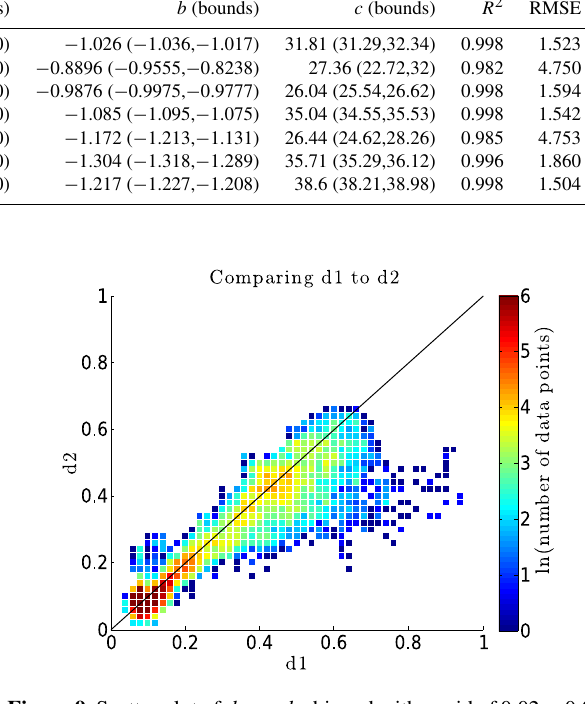
Figure 9. Scatter plot of d 1 vs. d 2 , binned with a grid of 0.02 × 0.02. Colour of point gives ln (number of data points at that particular ( d 1 , d 2 ) grid location). A 1:1 line is also given. This is not a regression, but demonstrates the basic equivalence of the two